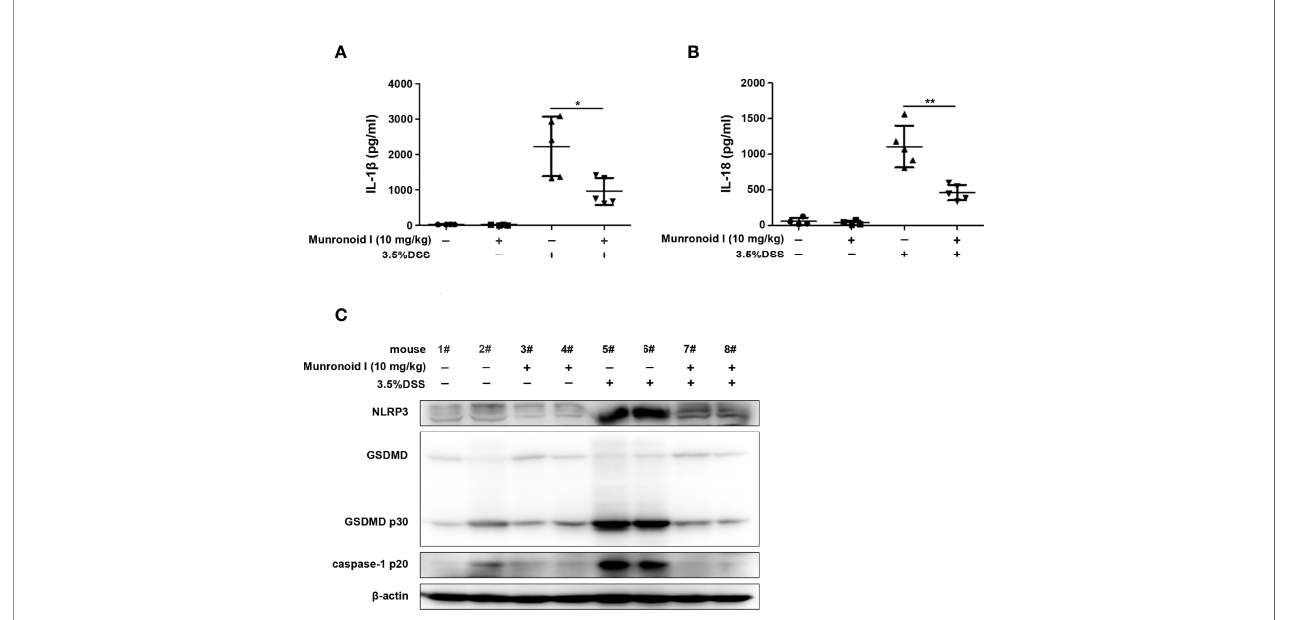
FIGURE 2 | Munronoid I reduced the in fl ammasome activation and pyroptosis in colon tissues from DSS-induced colitis mice. (A, B) One piece of colon for ELISA to analyze production of cytokine IL-1 b (A) and IL-18 (B) . (C) Western blot assay was used to detect pyroptosis related protein in the colon tissue. Data in A and B presented as the mean ± SD. *p<0.05,